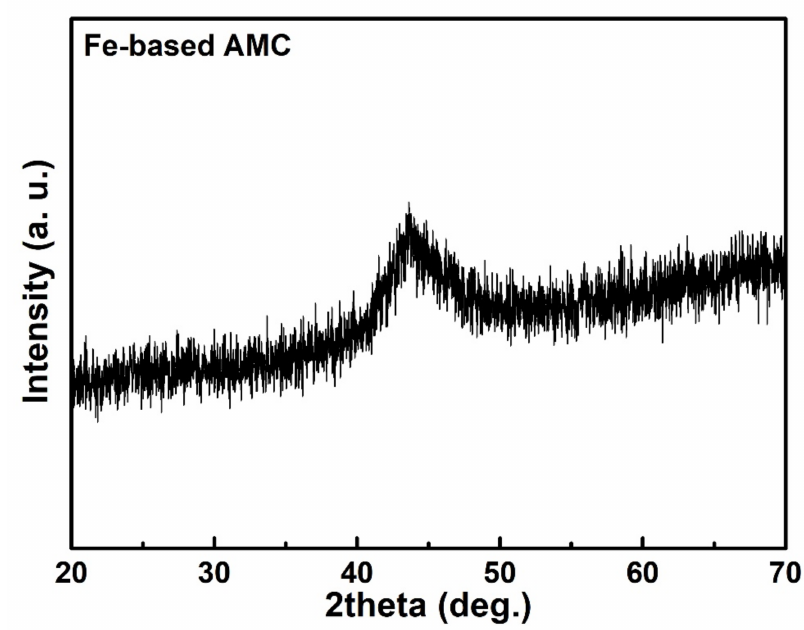
Figure 1. XRD pattern of the as-sprayed Fe-based AMC